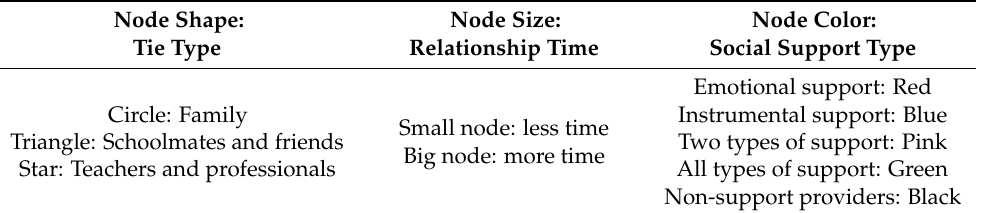
Figure 6. Case 4. Boy. 15 years old. School group. Table 7. Legend of